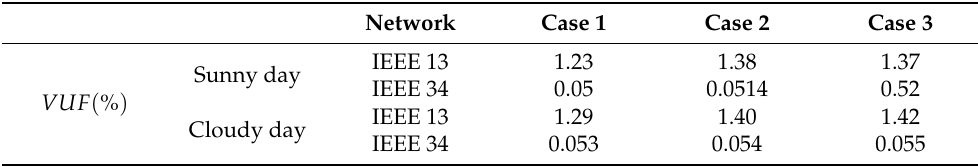
Table 2. Average VUF ( % ) for each case during both